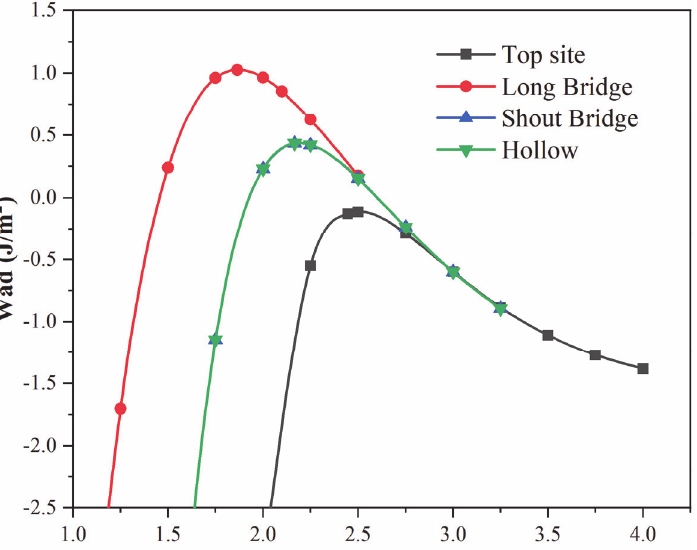
Figure 3. Universal binding energy relations for Cu(200)/AuCu(200) interface with four different stacking points.